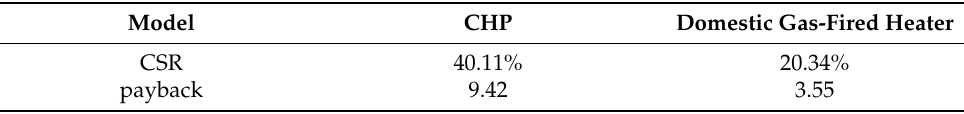
Table 3. CSR and payback for CHP and domestic gas-fired heater.